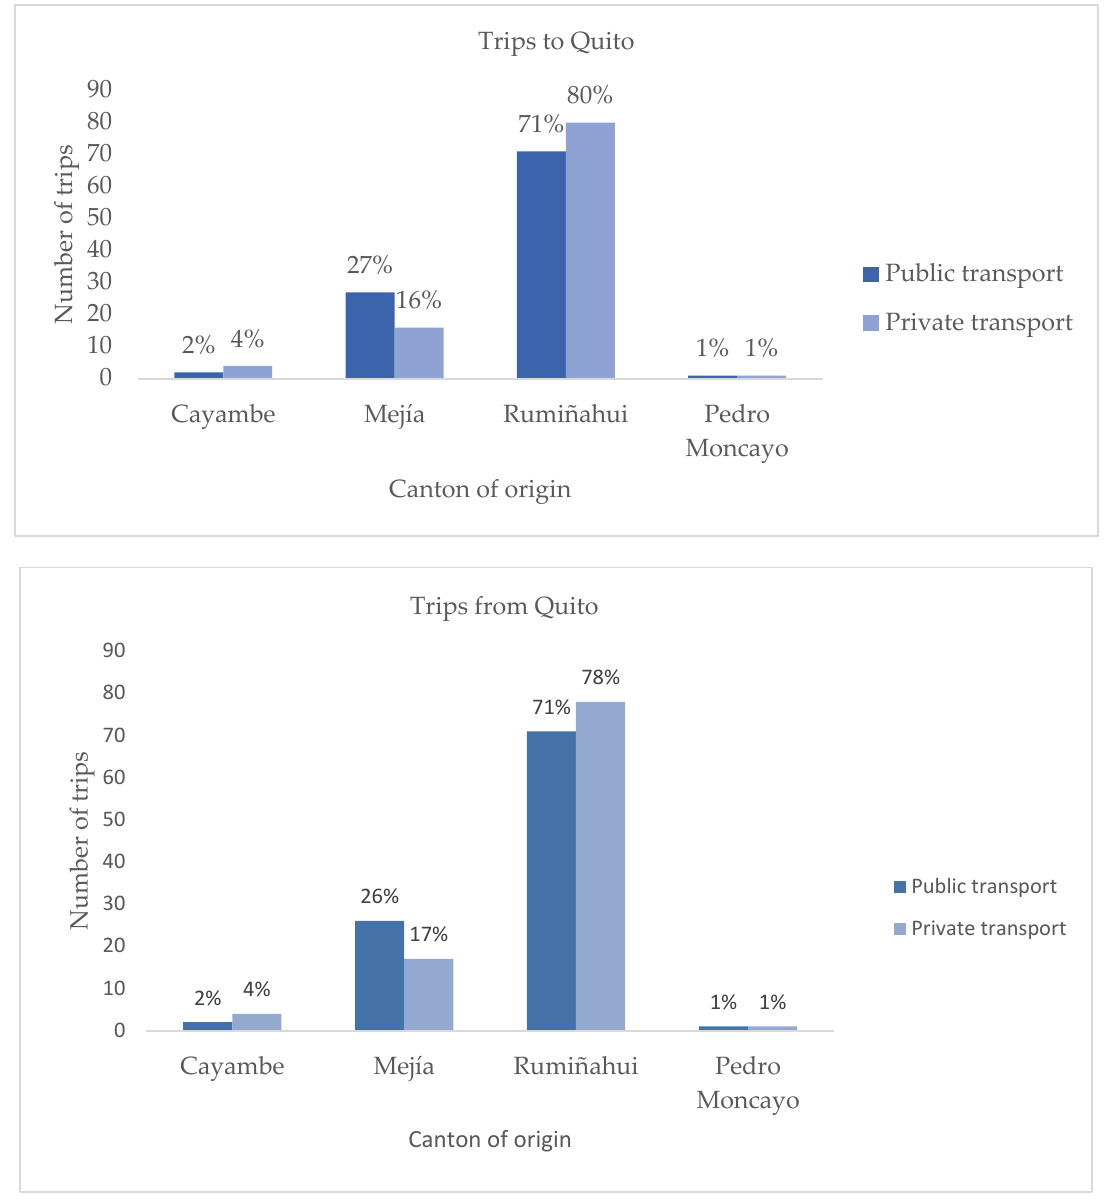
Figure 6. Trips to and from Quito of the NAMQ. Based on the 2011 mobility survey (Quito Metro, 2011).